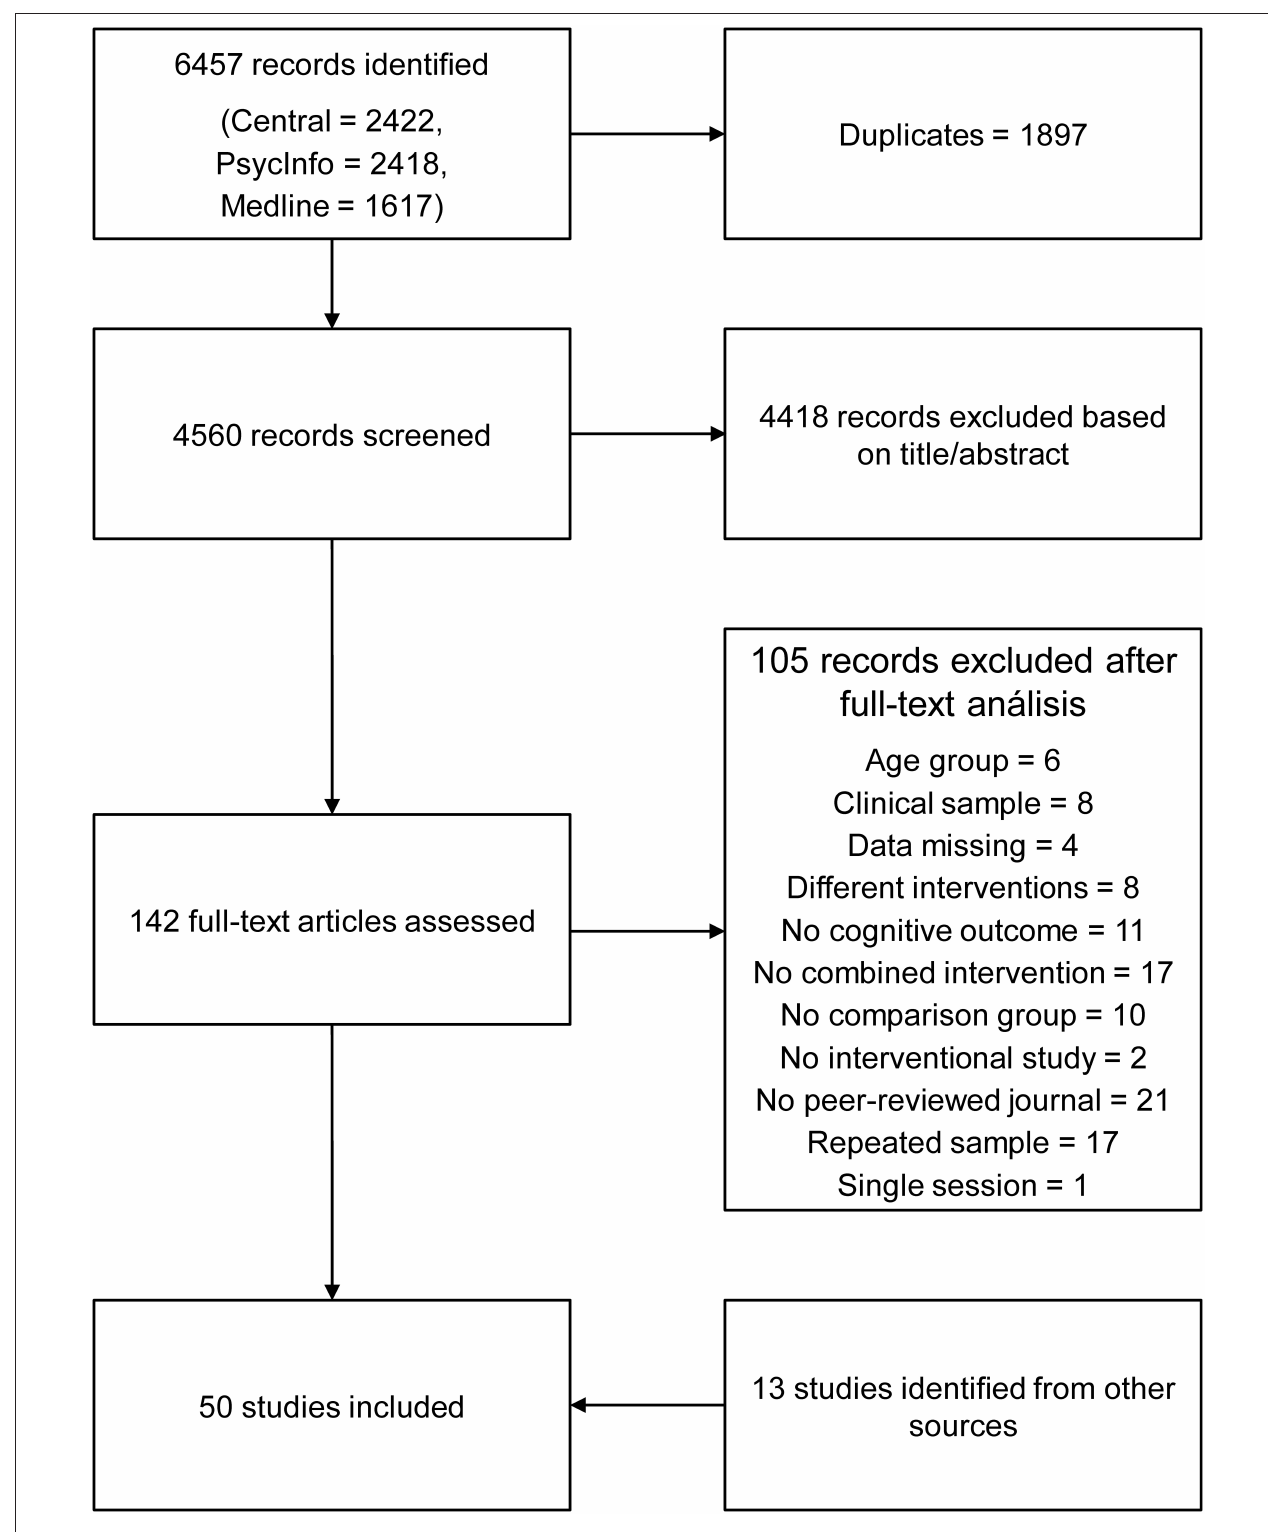
FIGURE 1 | PRISMA flow diagram of the search strategy.